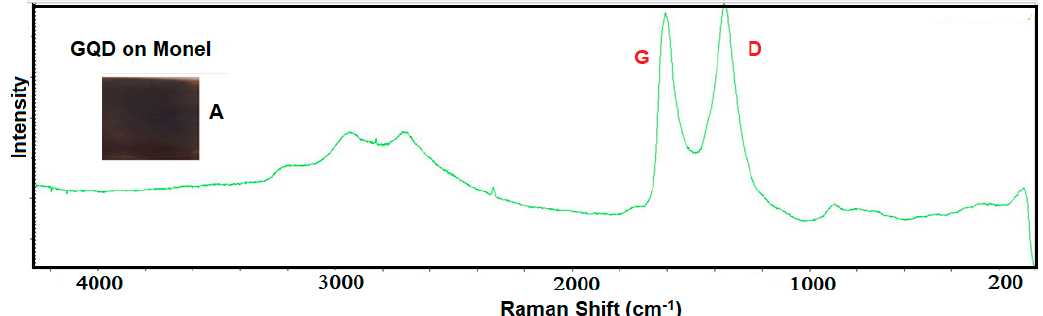
Figure 2. An optical image of Monel coated graphene quantum dots. Raman spectrum of the Monel adsorbed graphene quantum dots.